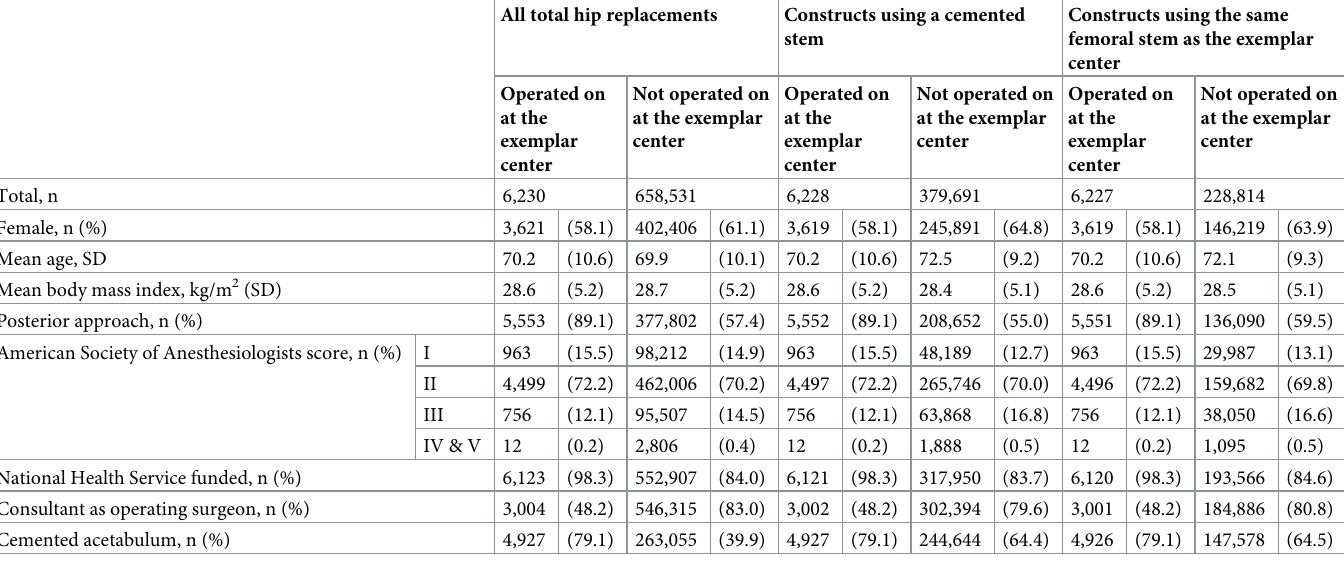
Table 1. Demographics and distribution of included total hip replacements.